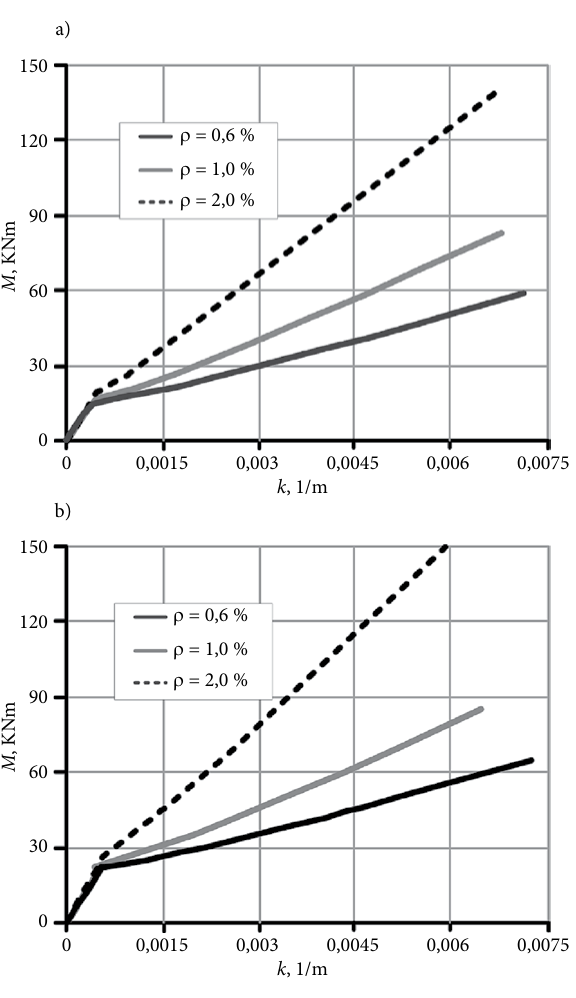
Fig. 2. Moment-curvature diagrams of ranging the grade of